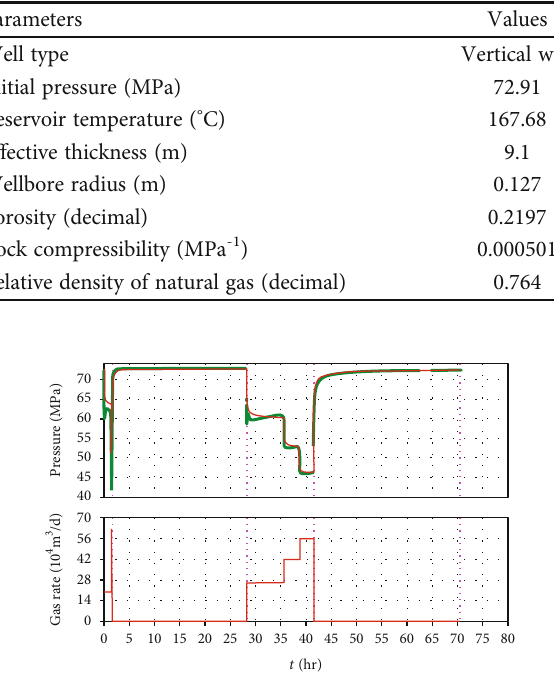
Figure 20: The pressure history of the well in the deepwater gas reservoir.